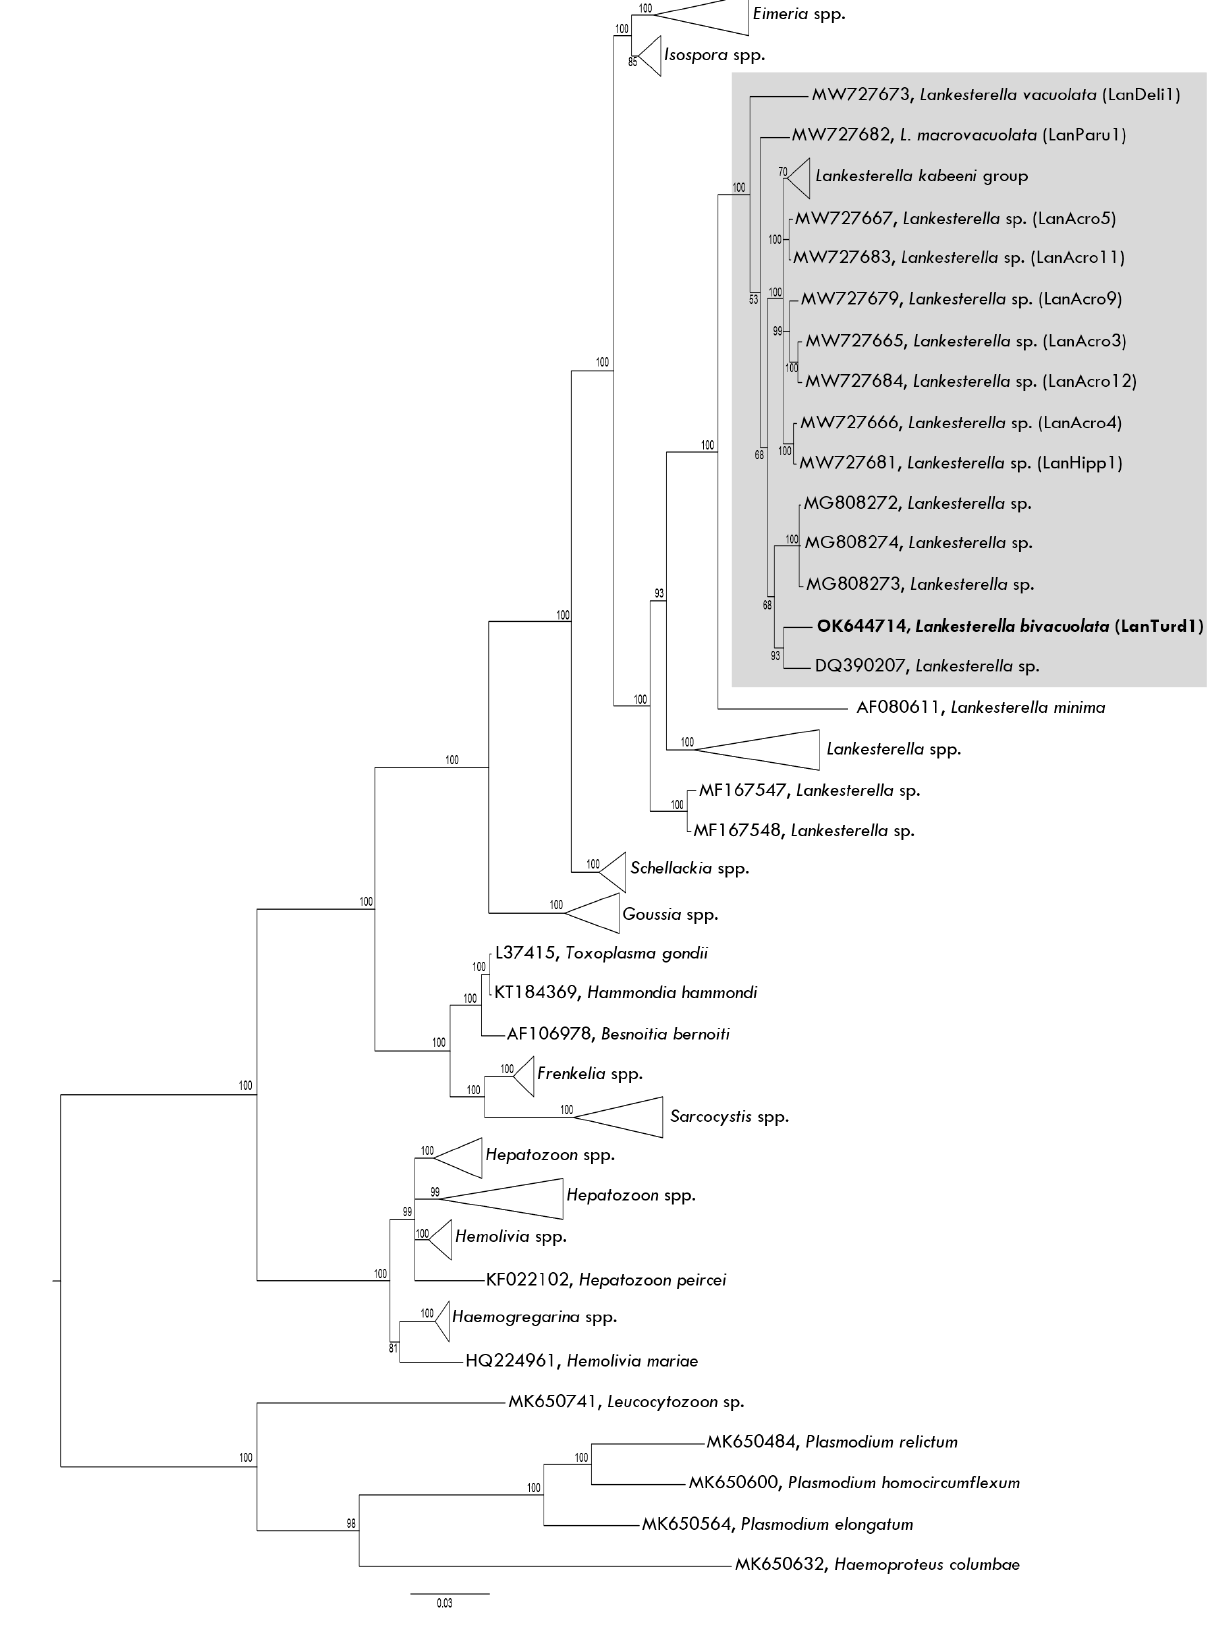
Figure 3. Bayesian phylogenetic inference tree based on the partial 18S rRNA gene sequences of Lankesterella parasites and other closely related Apicomplexa species. The tree was rooted with haemosporidian parasite DNA sequences. Lankes- terella bivacuolata n. sp. (LanTurd1) found in a Eurasian blackbird ( Turdus merula ) and other avian Lankesterella parasites